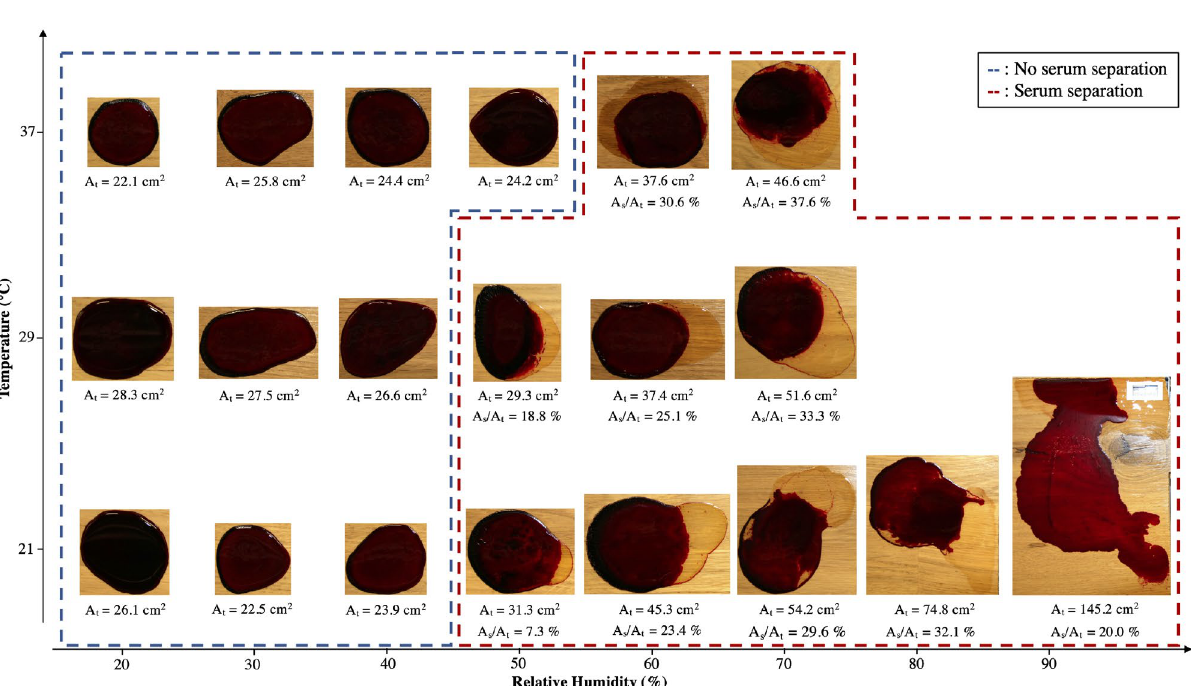
Figure 9. Phase separation during the spreading of blood pools ( m i = 4.82 g ± 0.5% , hct = 42.8% ± 2.6% ) as a function of relative humidity and temperature on varnished wooden floors. The blue box represents cases without phase separation, and the red box represents cases with phase separation. A t is the total area of the pool and A s / A t is the ratio between the serum area and the total pool